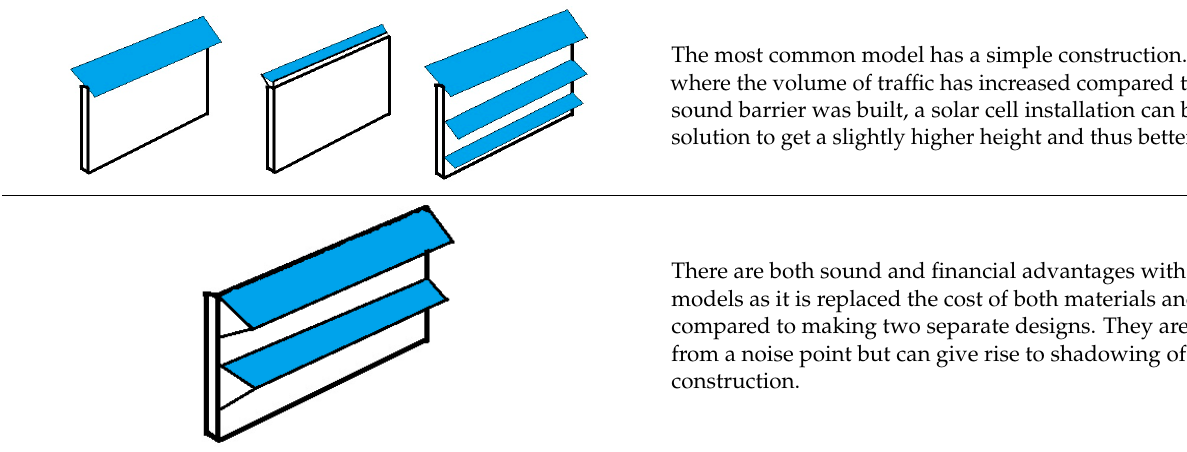
Table 6. Shadowless generation.